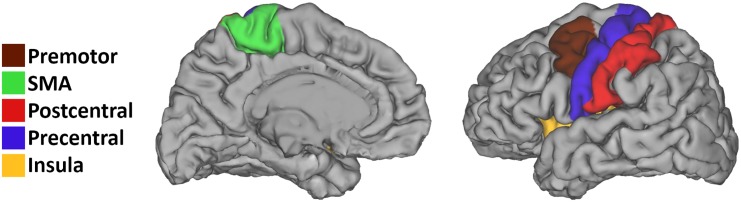
Surface reconstruction of a single subject with the anatomical motor segments depicted by different colors.